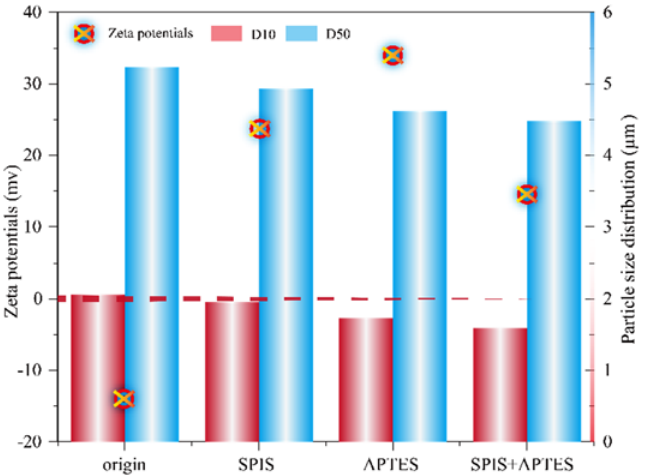
Figure 8. Average size and zeta potential of the surface ‐ modified QP without and with the SCAs.